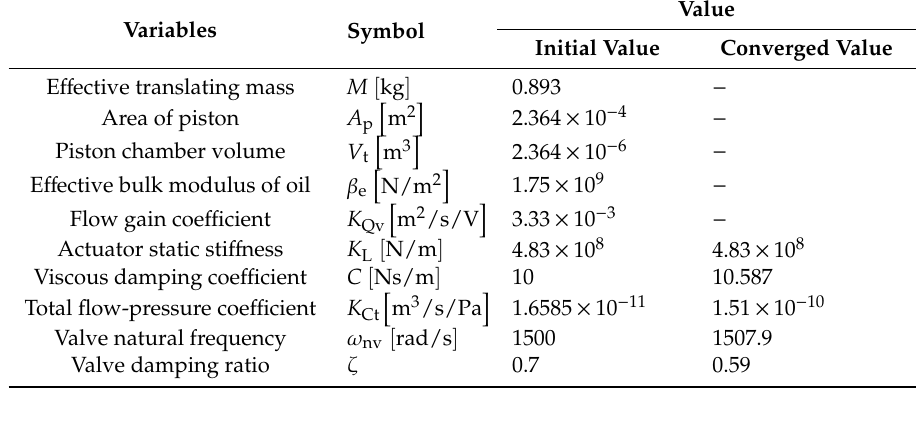
Table 1. Model parameters of the electro-hydraulic actuator system.